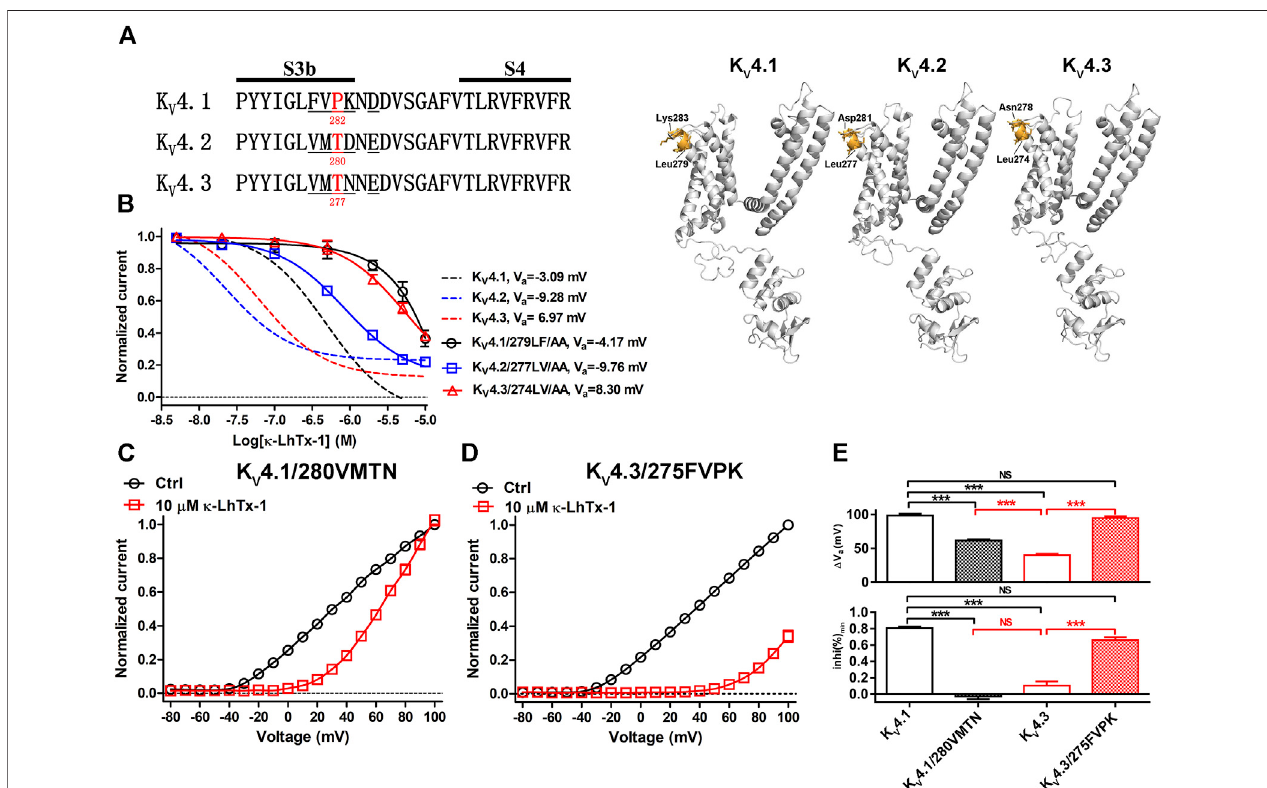
FIGURE 3 | Characterizing the non-conserved S3b segments in K V 4.1 and K V 4.3 as the key molecular determinants. (A) , Left: sequence alignment of the K V 4 channels ’ S3b-S4segments,thenon-conservedS3bregionsareunderlined,andthenumberbelowtheresidueindicatesitslocationinthesequence(inmK V 4.1,rK V 4.2 andrK V 4.3numbering);Right:Locationsofthenon-conservedS3bsegmentsinthesimulatedstructuresofK V 4.1 – 4.3channelsasdeterminedbySWISS-MODELusing 5WIE (PDB ID) as the template (https://swissmodel.expasy.org/), note only one subunit for each channel was shown for clarity. (B) , The concentration-response curvesof κ -LhTx-1inhibitingtheK V 4.1/279LF/AA,K V 4.2/277LV/AAandK V 4.3/274LV/AAmutantsattheirrespectiveV a depolarizingvoltages(n (cid:2) 5 – 7).Forcomparison, the curves for wild-type K V 4.1, K V 4.2 and K V 4.3 were shown in dashed lines. K V 4.1/279LF/AA, K V 4.2/277LV/AA and K V 4.3/274LV/AA were made by mutating